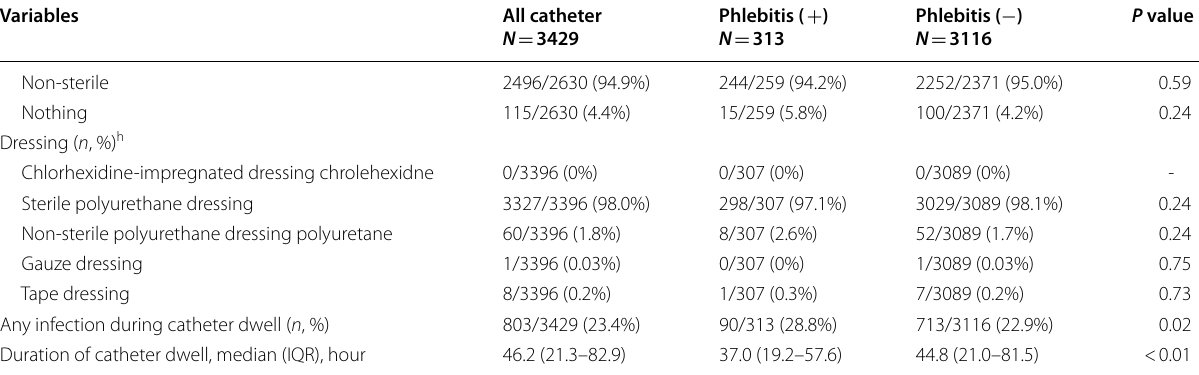
Table 3 Comparison of the drugs administrated via PIVC with or without phlebitis